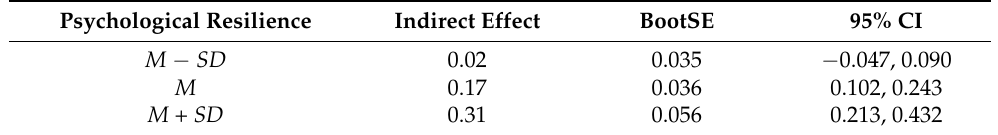
Table 4. The moderated indirect